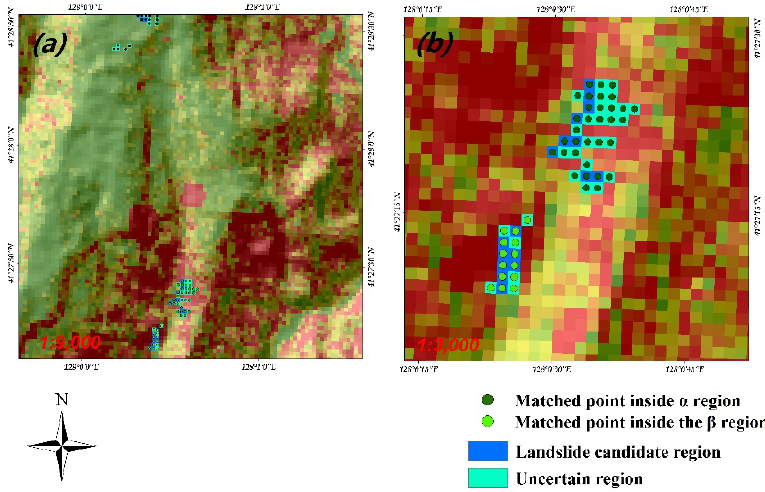
Figure 11. ( a ) Different color point. ( b ) Final results.